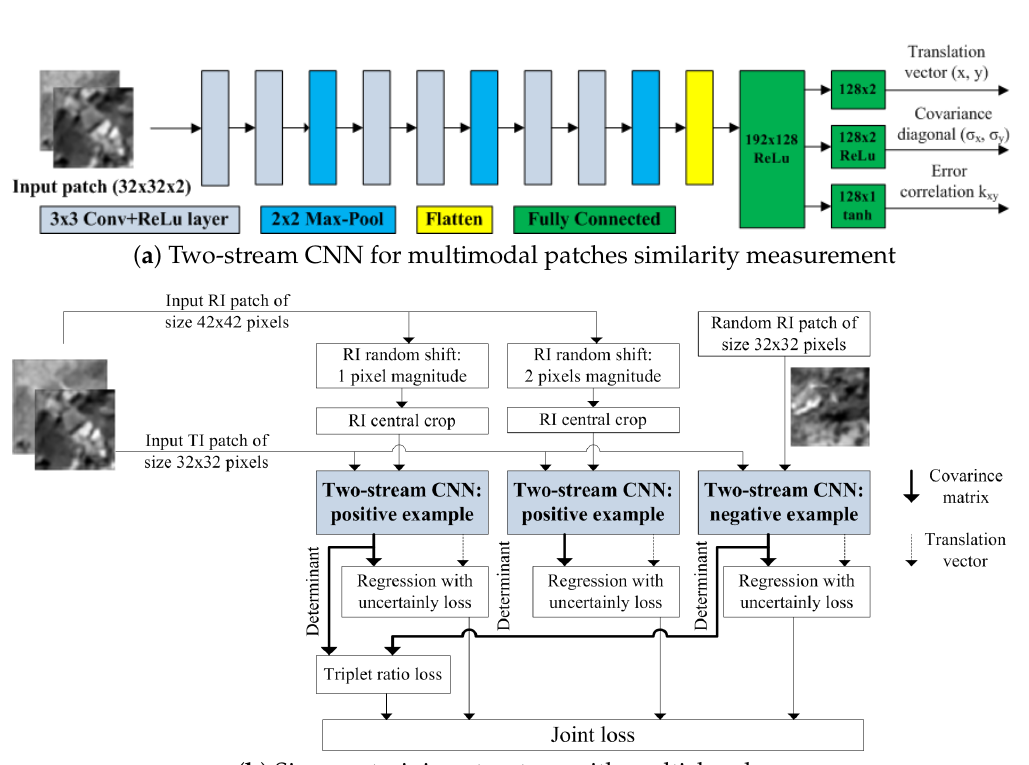
Figure 3. The proposed Siamese CNN